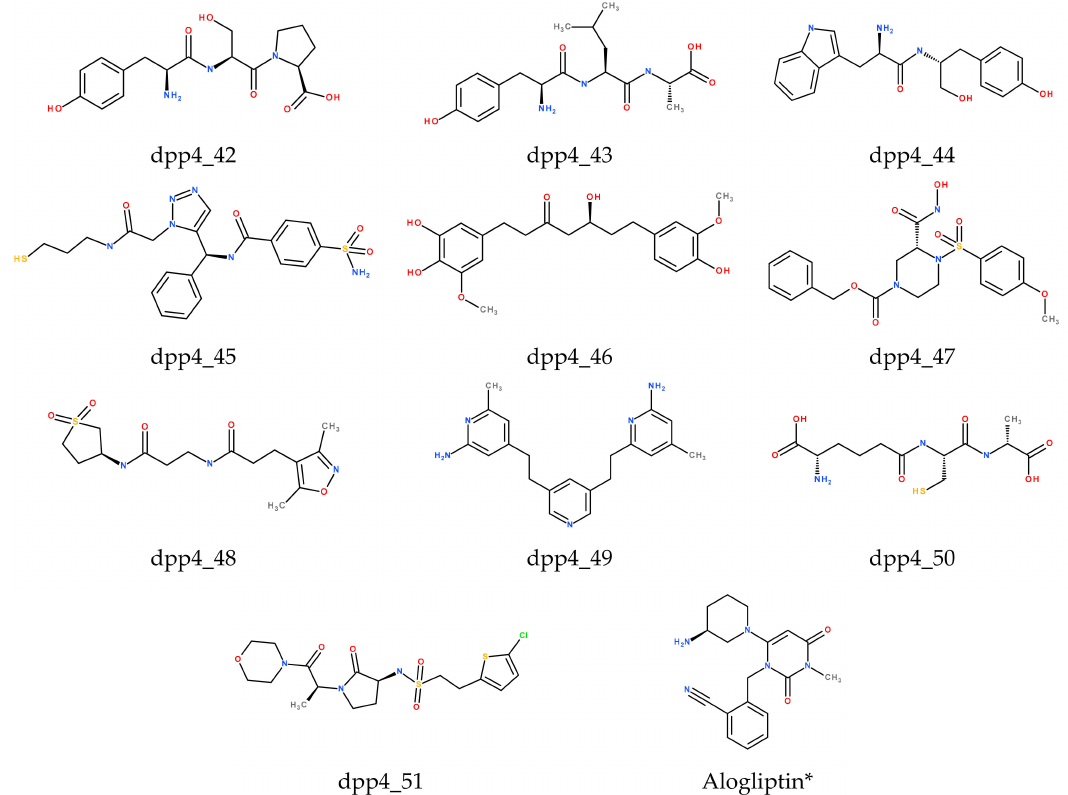
Figure 2. Structures of the top 11 docking compounds for DPP- IV